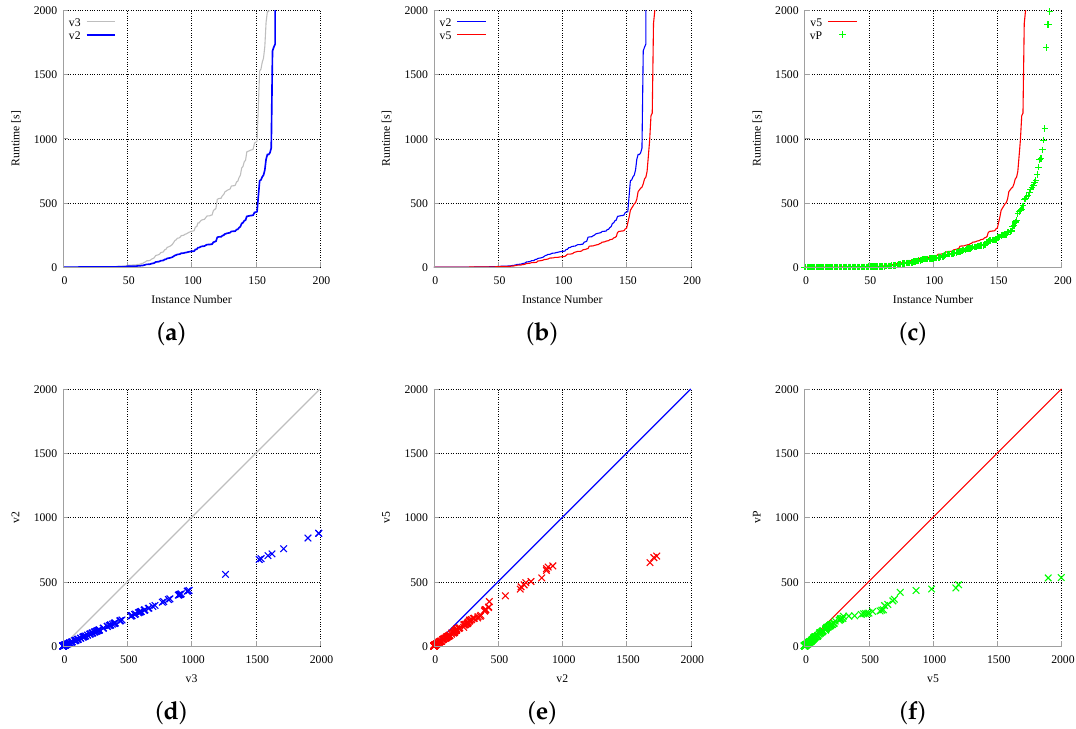
Figure 12. Analysis of all main resolution strategies: v 3 sequential, v 4 multi-core CPU based, v 5 many-core GPU based, and vP portfolio. Each graphic reports sorted resolution times ( a – c ) or the related scatter plot ( d – e ) comparing these strategies